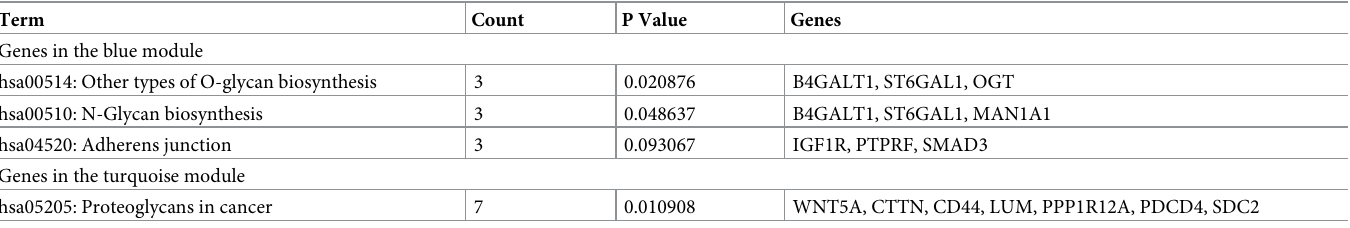
Table 4. The KEGG pathway enrichment analysis of the genes in the ceRNA